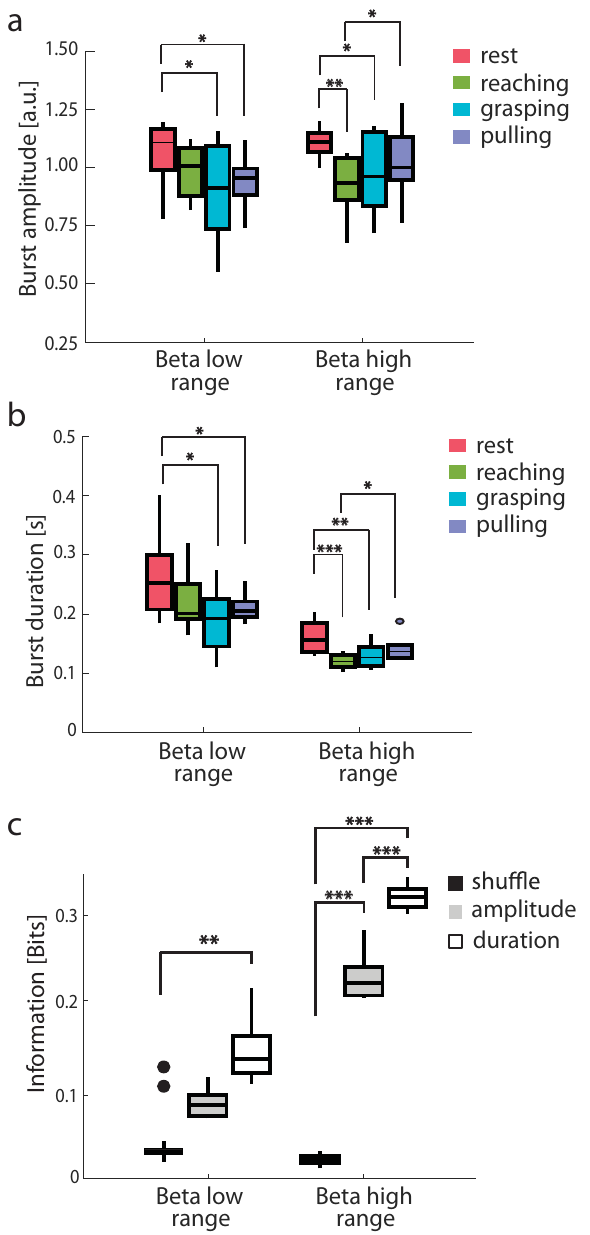
Fig. 3 Burst analysis for beta ranges selected according to information analysis. a Group median amplitude of the bursts in beta low range (14 ± 2 Hz) and beta high range (24 ± 2 Hz) during the reach-to-grasp task. b Same as a for burst duration. c Group median information about the reach-to-grasp task carried by the amplitude (gray) and the duration (white) of the beta bursts. Information carried by a shuf fl e permutation (black) served for statistical signi fi cance. Boxplots are drawn between the 25th and the 75th percentiles, with a horizontal line indicating the median. The whiskers extended above and below to the most extreme data points within 1.5 times the interquartile range. Asterisks denote the statistical signi fi cance * p < 0.05, ** p < 0.01, and *** p < 0.001 of the permutation test (PT). See also Supplementary Figs. 7 and